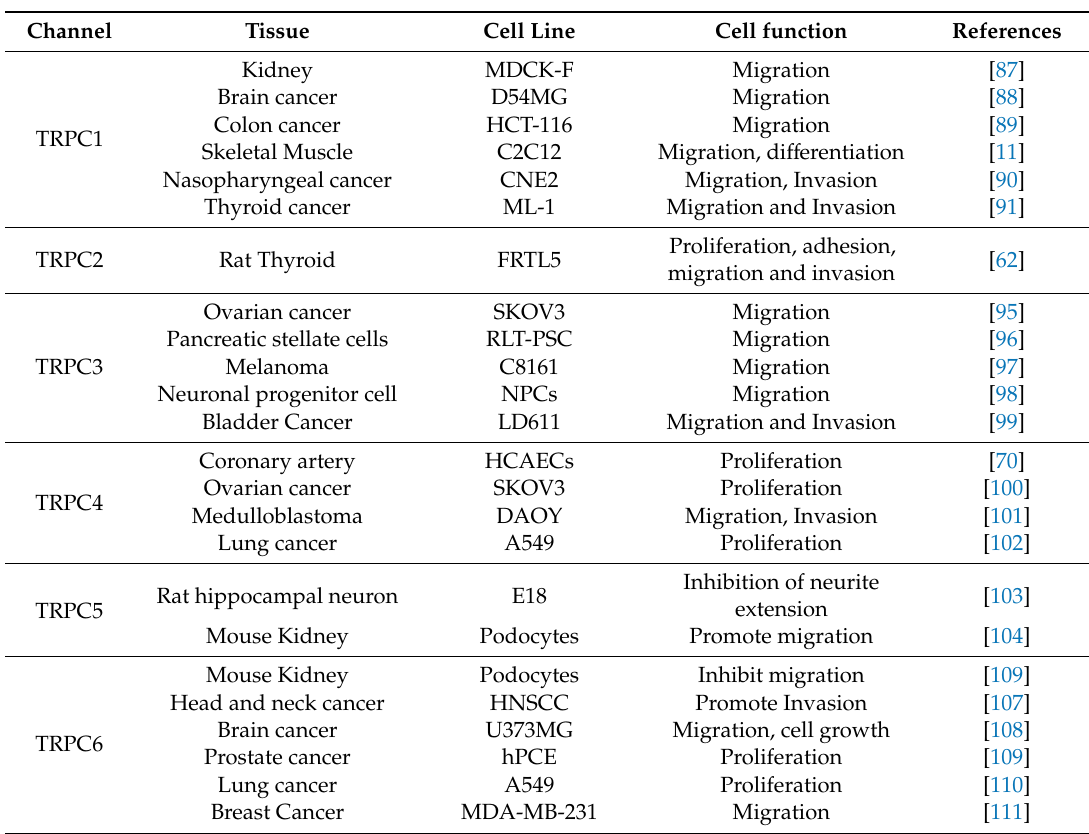
Table 2. E ff ects of TRPC channels on invasion, migration, and